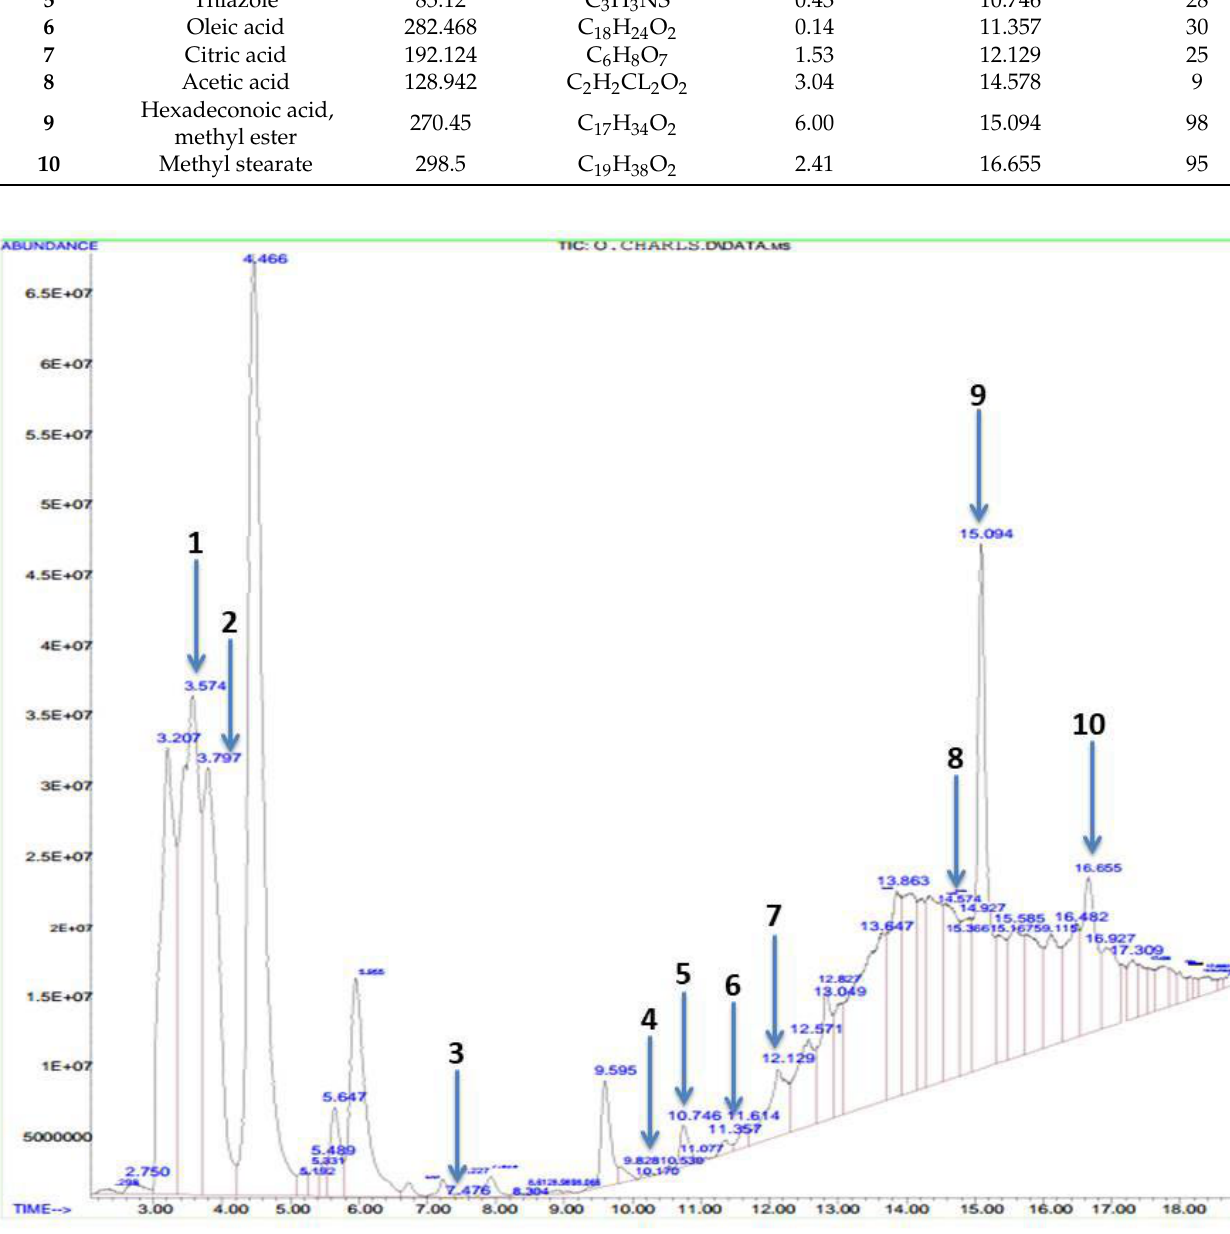
Figure 1. GC-MS analysis of methanolic P. amarus leaf extract. 1: Butanoic acid, 2: methenamine, 3: cy- clobutane, 4: octanoic acid, 5: thiazole acid, 6: oleic acid, 7: citric acid, 8: acetic acid, 9: hexadecanoic acid, 10: methyl